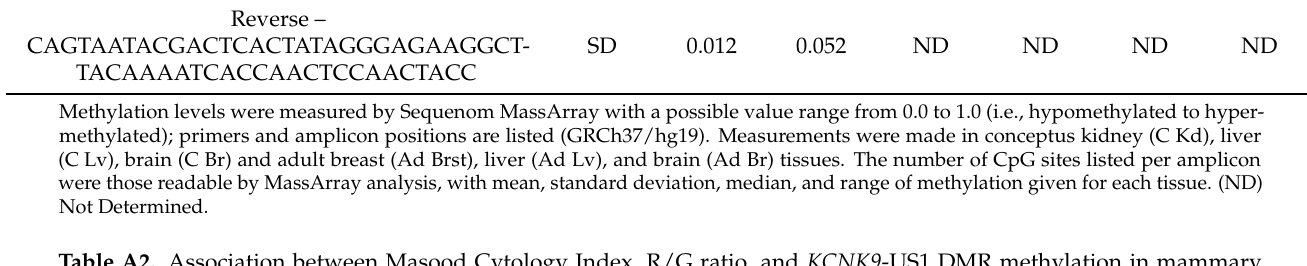
Table A2. Association between Masood Cytology Index, R/G ratio, and KCNK9 -US1 DMR methylation in mammary epithelial